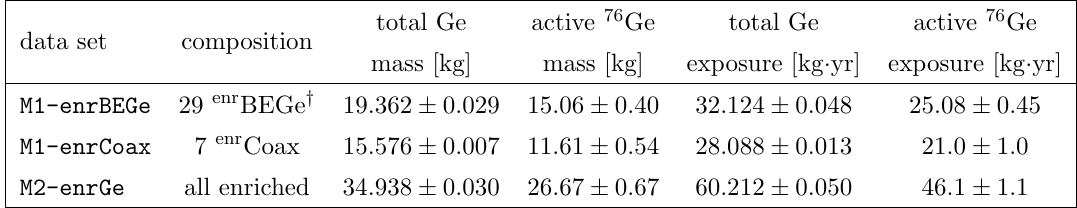
Table 1. Properties of the data sets considered in this analysis. Further details about the Gerda detectors can be found in past publications [13,